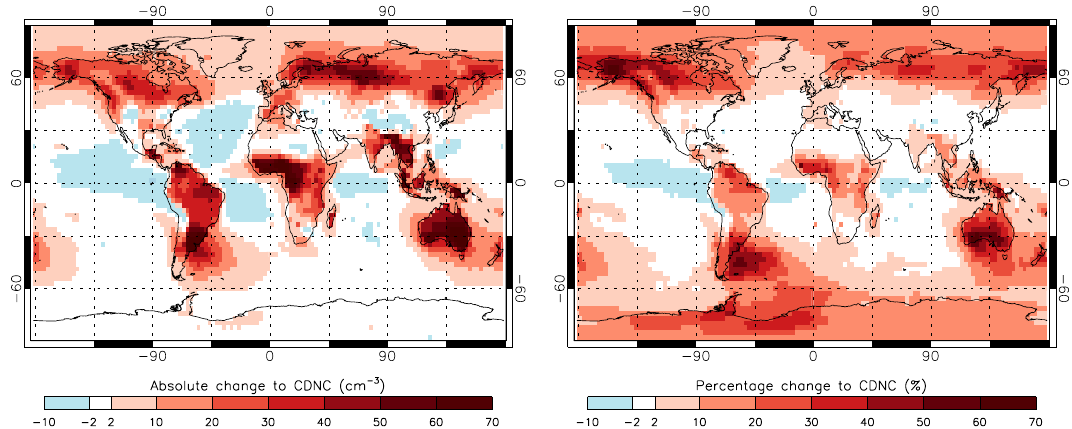
Fig. 5. Annual mean absolute (left) and percentage (right) change to CDNC due to biogenic SOA when the ACT nucleation mechanism is used (i.e. [CDNC] expt . 4 –[CDNC] expt . 1 )